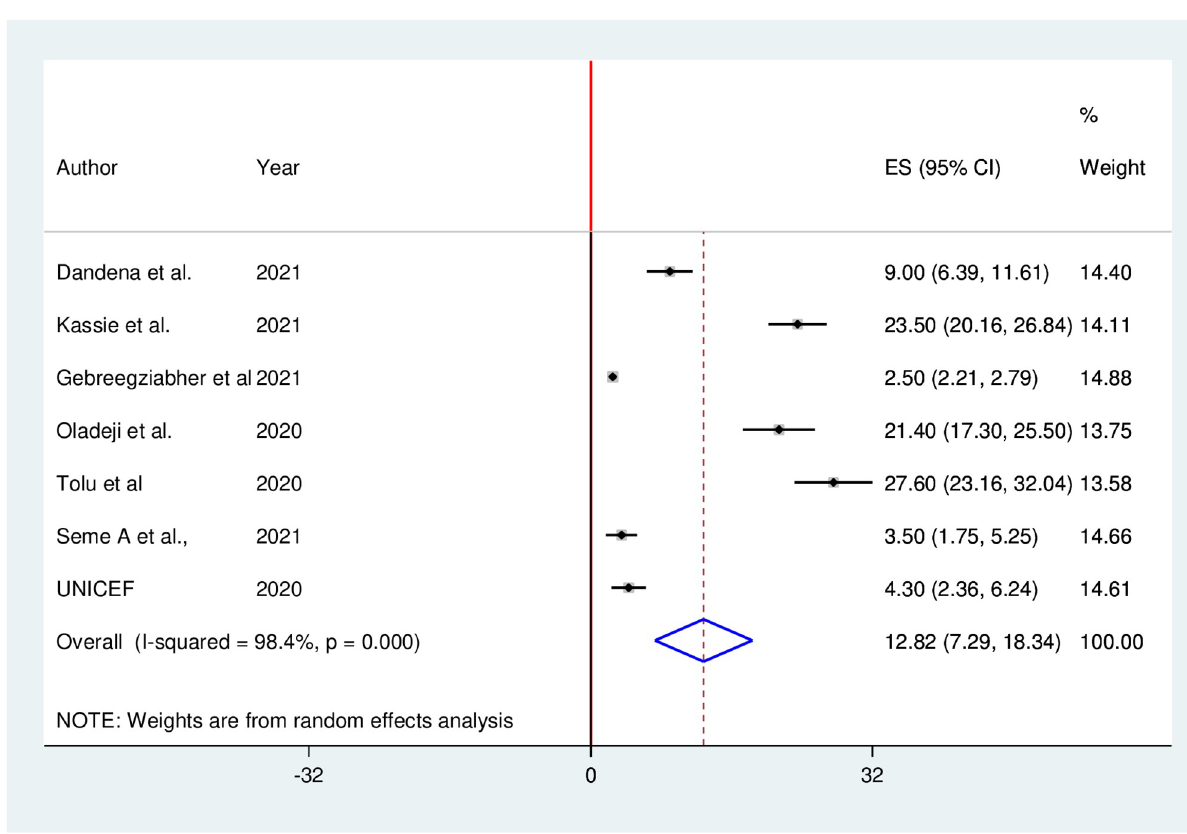
Fig 8. Forest plot of the pooled reduction of institutional delivery services utilization during COVID-19 pandemic in Ethiopia, 2021.